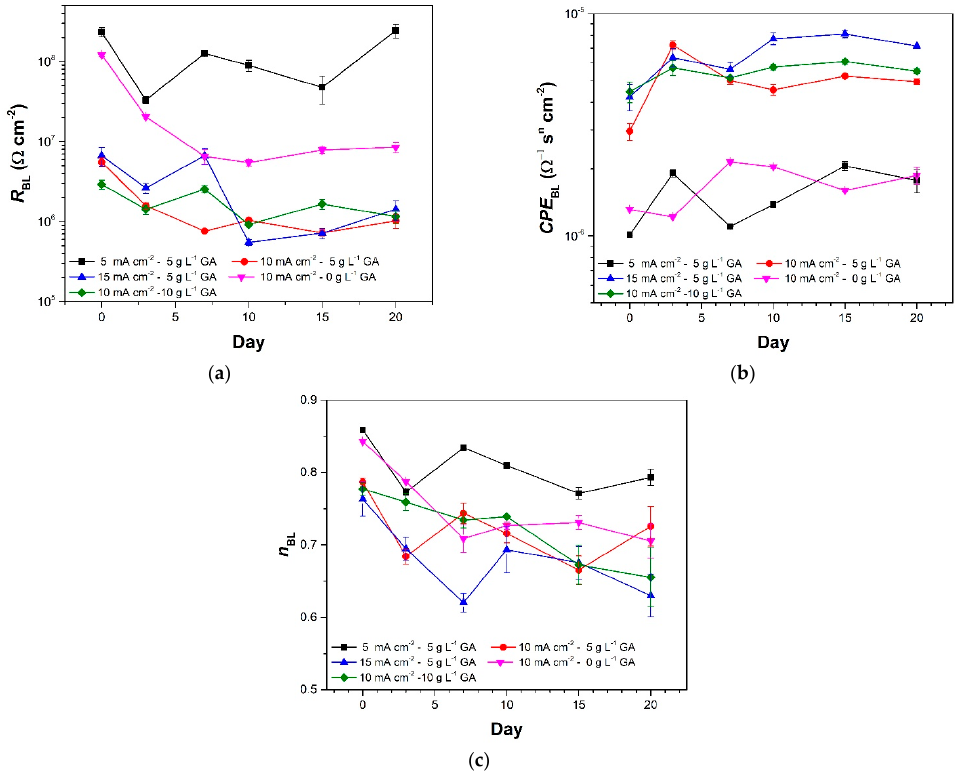
Figure 8. Fitted values of the barrier layer ( a ) resistance, ( b ) constant phase element, and ( c ) n of the anodized aluminum samples at different times during the prolonged immersion in 3.5 wt.% NaCl. The error bars in the plots pertain to the standard error of based on three replicates.